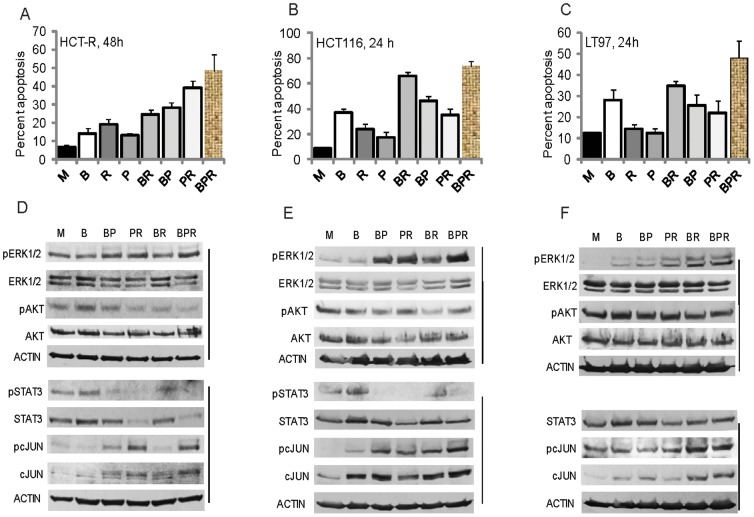
The combination treatment of butyrate, propolis, and coffee extract induces highest levels of apoptosis in colon adenoma and carcinoma cells.A–C. Cells were exposed to mock (M), 5 mM butyrate (B), 1 mg/ml roasted coffee extract (R), 100 µg/ml propolis (P), butyrate and coffee extract (BR), butyrate and propolis (BP), propolis and coffee extract (PR), or butyrate, propolis and coffee extract (BPR). Apoptosis was measured by flow cytometry as described in Materials and Methods. D–F. Cells were exposed to treatments as described above for 17 h, and total cell lysates were analyzed by western blotting.